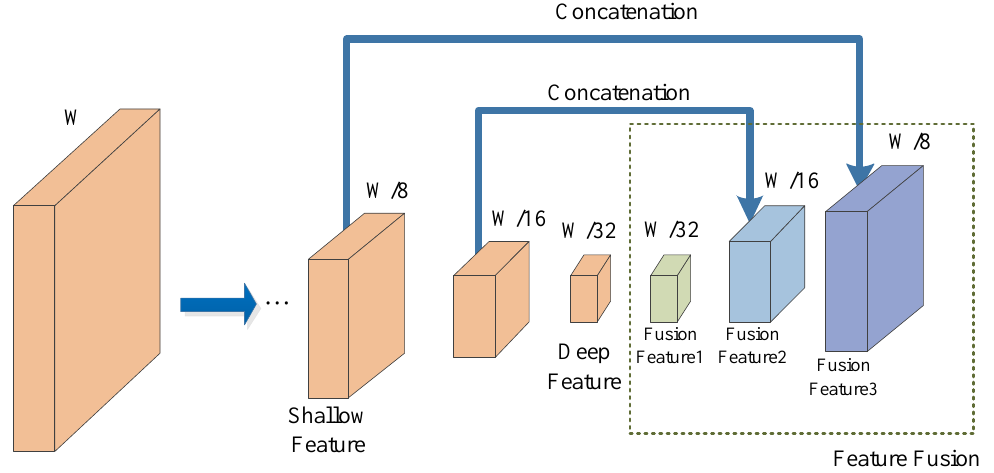
Figure 8. Convolutional feature fusion structure. Concatenation operations are used to fuse shallow convolutional features and deep convolutional features, which is beneficial to achieve multi-scale detection of ships. Meanwhile, fused features are helpful for detecting small targets.